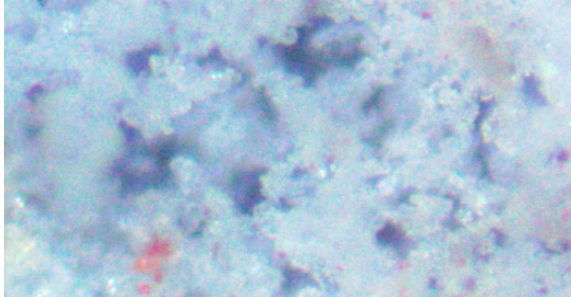
Figure 11. (ST2a Trial [16]) ZVI Product. Halite crystals partially infilling a pore and increasing pore tortuosity. The red-brown mineral is molysite (FeCl 3 ). Molysite occurs naturally in halite assemblages, e.g., [53]. Reflected light. Field of view = 0.099 mm; ZVI:water ratio = 28.53 g/L; Feed water salinity = 9.61 g/L; Product water salinity after 230 days = 2.62 g/L. NaCl removed = 6.99 g/L (0.25 g/g ZVI). Feed water pH = 6.31; Product water pH = 8.40.